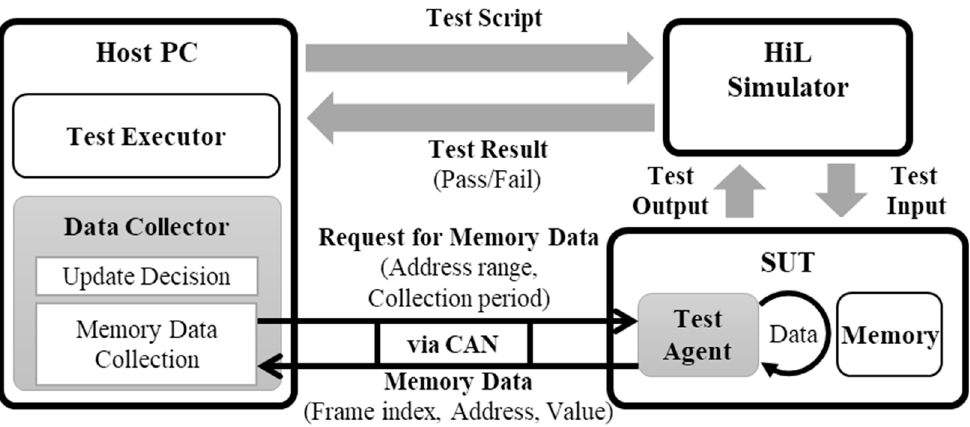
Figure 4. Data collector in HiL test environment.